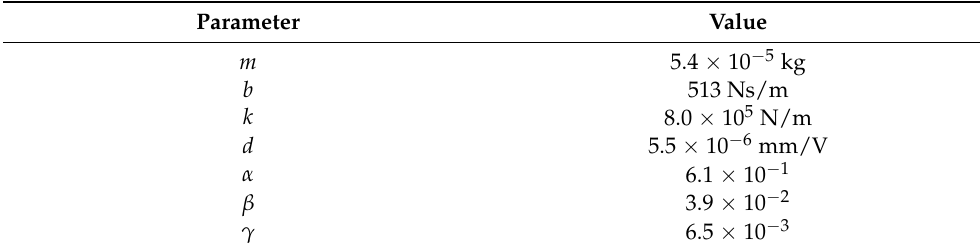
Figure 6. Comparison between the measured outputs and the model outputs at 1 Hz. Table 2. Parameters of the hysteresis model.